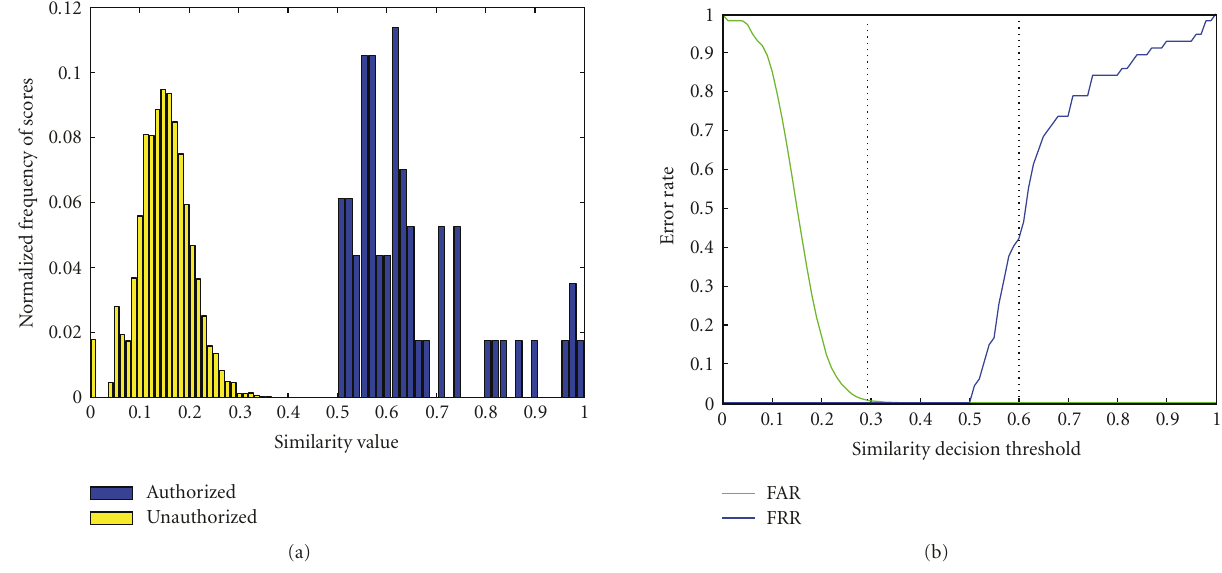
√ MN as normalisation function for the